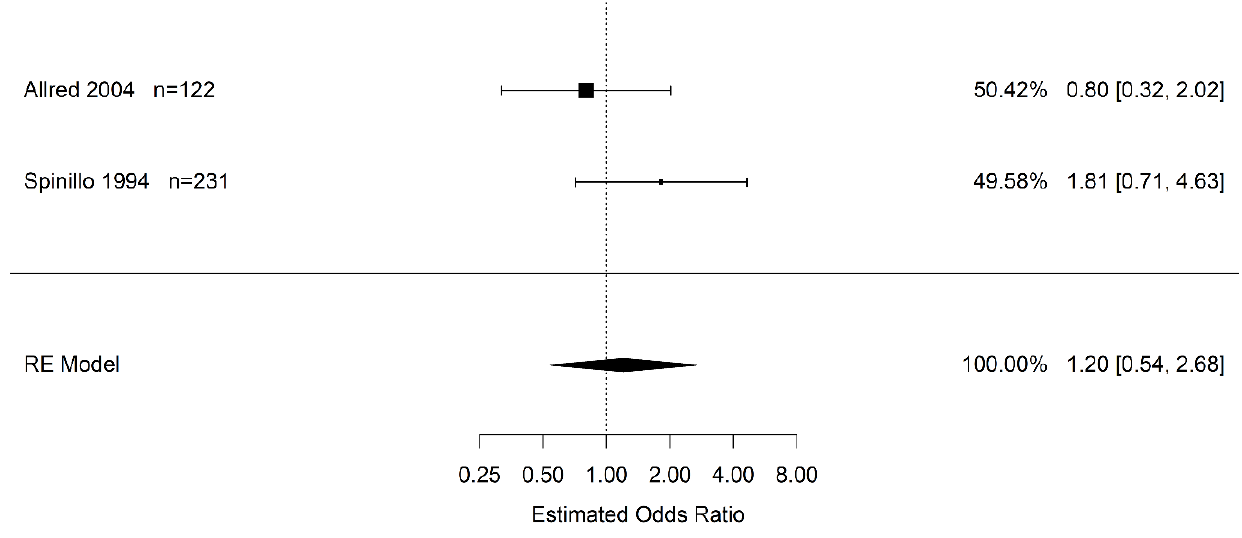
Figure 3. Estimate odds ratio of placental abruption (vs. “controls”) for severe intraventricular hemorrhage (grade 3, 4) calculated using random effects (RE) model. [30,45,50]